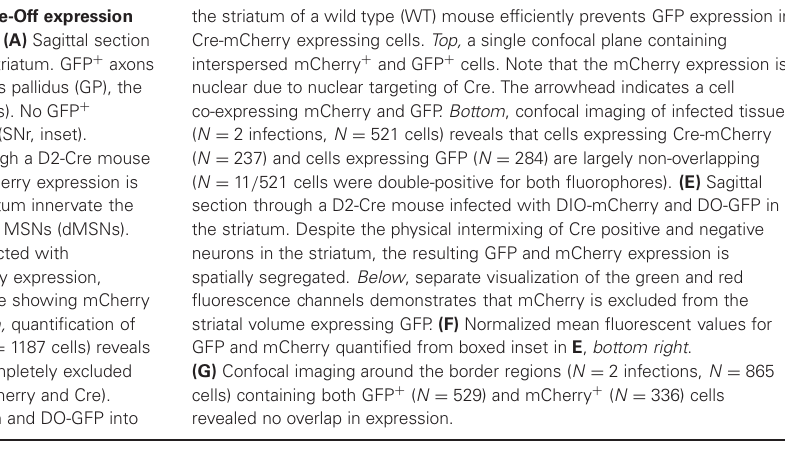
FIGURE 2 | DIO and DO rAAVs achieve Cre-On and Cre-Off expression but exhibit interfering interactions when co-infected. (A) Sagittal section through a D2-Cre mouse infected with DIO-GFP in the striatum. GFP + axons emanating from the striatal infection innervate the globus pallidus (GP), the target of indirect pathway medium spiny neurons (iMSNs). No GFP + expression is observed in the substantia nigra reticulata (SNr, inset). COR = cortex, STR = striatum. (B) Sagittal section through a D2-Cre mouse infected with DO-mCherry in the striatum such that mCherry expression is excluded from iMSNs. mCherry + axons leaving the striatum innervate the SNr (inset), consistent with expression in direct pathway MSNs (dMSNs). (C) Antibody staining against Cre in D2-Cre striatum infected with DO-mCherry reveals that Cre efficiently turns off mCherry expression, indicative of Cre-Off behavior. Top , a single confocal plane showing mCherry expression excluded from cells with Cre + nuclei. Bottom, quantification of co-expression of Cre and mCherry ( N = 4 infections, N = 1187 cells) reveals that mCherry expression ( N = 495 cells) was almost completely excluded from Cre + cells ( N = 1 / 691 cells double-positive for mCherry and Cre). (D) Co-infection of rAAVs encoding a Cre-mCherry fusion and DO-GFP into